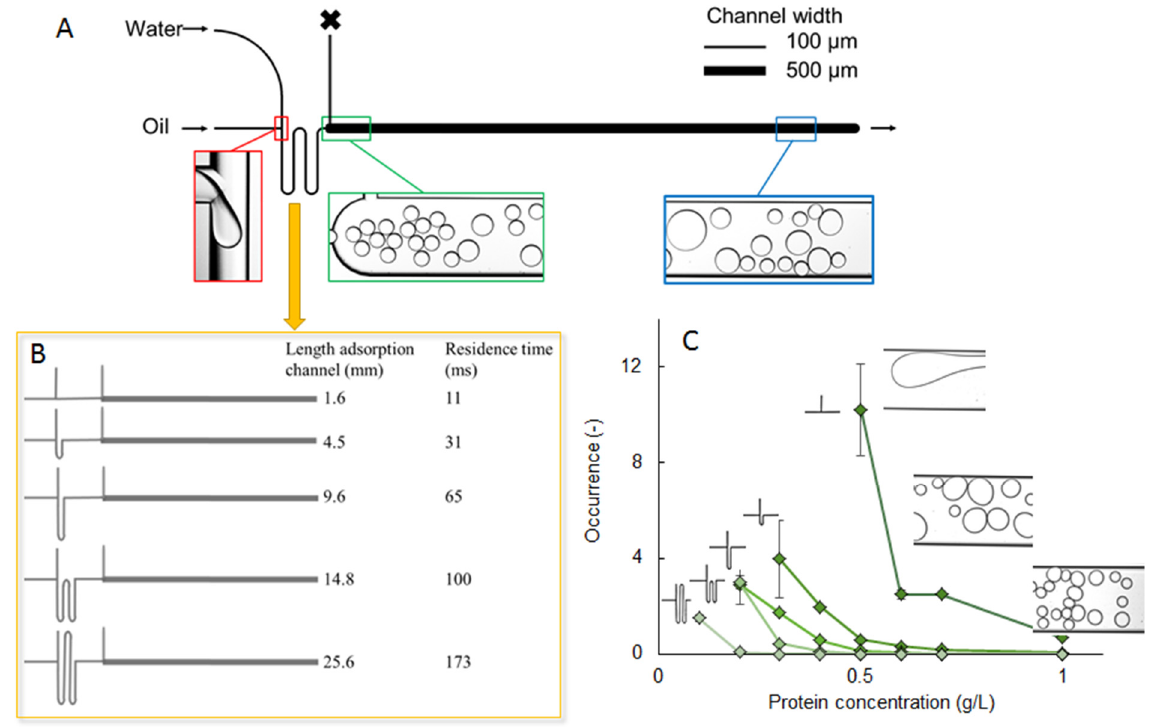
Figure 8. ( A ) General design of the coalescence chip. The droplets are generated at the T-junction (red square), after which they are transported through the meandering channel (which may have different length—panel B ) to the coalescence chamber where images are collected (green and blue squares in panel A ), and related to the number of coalescence events that took place (reprinted from [83], with permission from Elsevier). ( C ) Typical data from the coalescence chip, showing the occurrence of oil droplet coalescence for various concentrations of pea proteins in the aqueous phase, when systematically changing the stabilization time through the length of the meandering channel. The microscopy pictures on the right of panel C illustrate typical appearance of the droplets at the exit of the coalescence chamber [84], under the CC BY license 4.0.